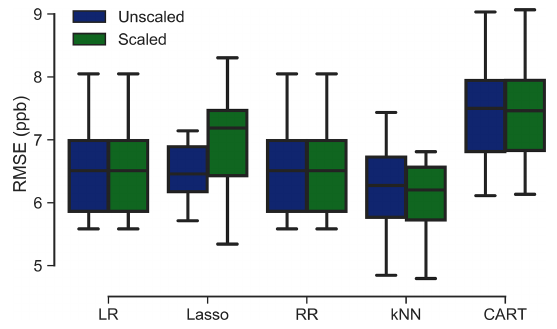
Figure 4. Box-and-whisker plots showing results from the initial spot-check of various algorithms – linear regression (LR), least absolute shrinkage and selection operator regression (LASSO), ridge regression (RR), classification and regression tree regression (CART), and k nearest neighbors regression ( k NN) – to deter- mine their ability to quantify SO 2 using three independent variables (V WE , V AE , and T ). Each box represents the interquartile range, with the whiskers describing the minimum and maximum values. Each algorithm was run on data that were as-is (“unscaled”, blue boxes) and normalized by removing the mean and scaling to unit variance (“scaled”, green boxes). Results shown are for a single sen- sor (SO2-02) covering 145467 1min data